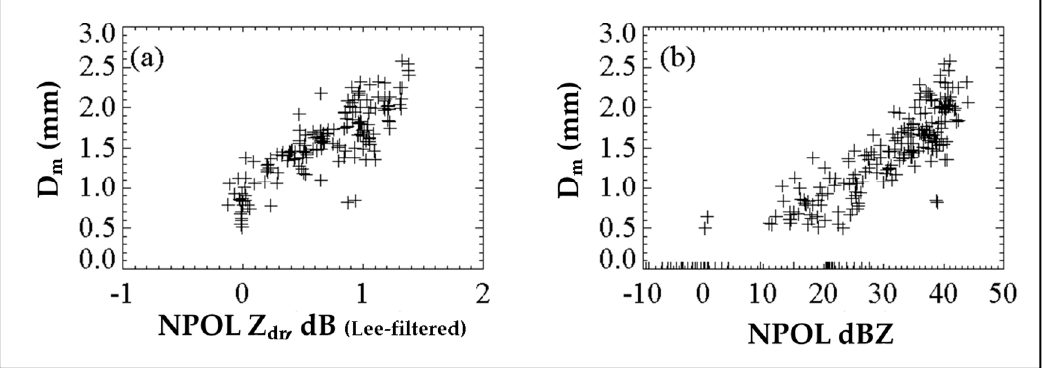
Figure 8. Mass ‐ weighted mean diameter from 3 min DSDs versus ( a ) NPOL ‐ based Lee ‐ filtered Z dr Figure 8. Mass-weighted mean diameter from 3 min DSDs versus ( a ) NPOL-based Lee-filtered Z dr and and ( b ) NPOL ‐ based Z h over the disdrometer site. ( b ) NPOL-based Z h over the disdrometer